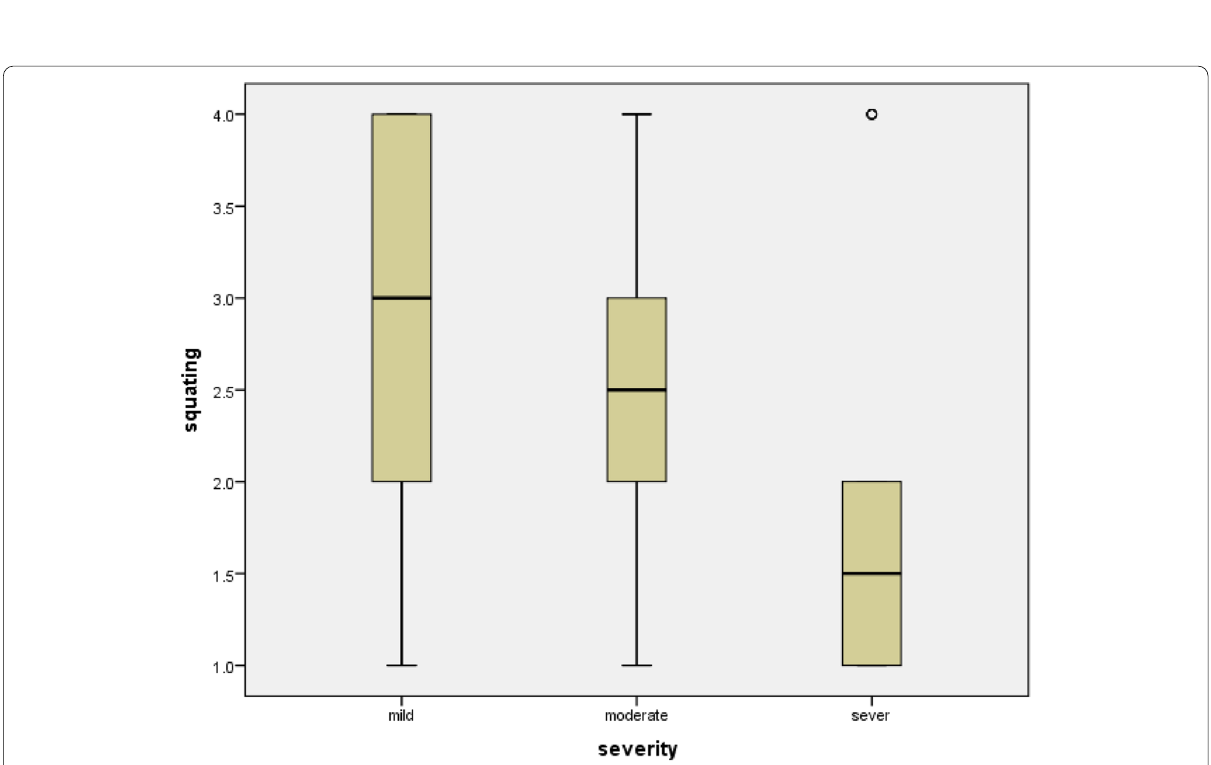
Fig. 5 Squatting score according to severity of